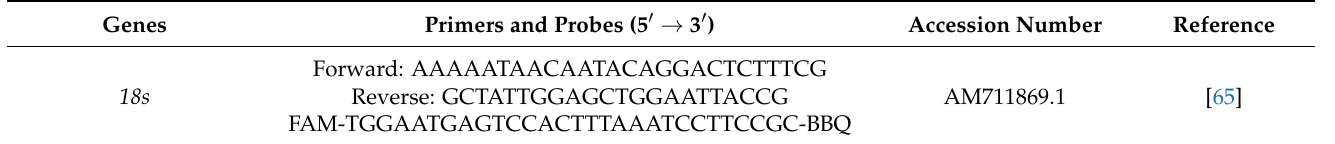
Table 9. Primers and probes used for TaqMan TM assays.